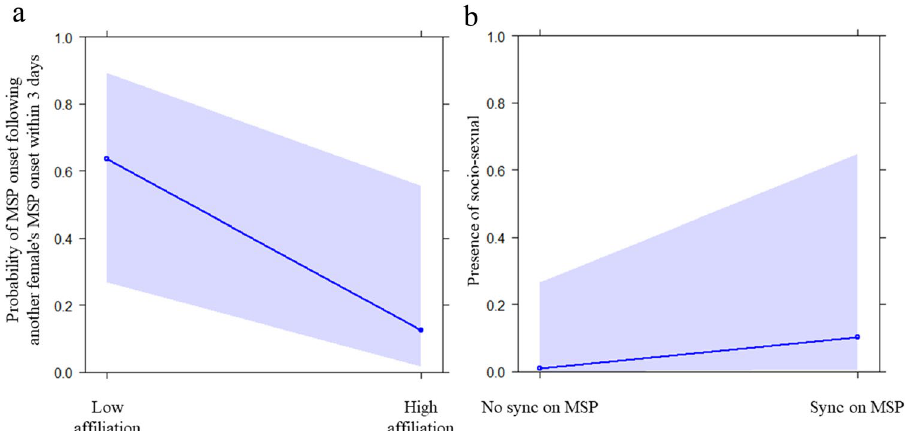
Figure 4. Effect plot of the variables having a significant influence on the occurrence of socio-sexual contacts in GLMM 2 and GLMM 3 ( a,b ; Table 2). ( a ) The probability of the MSP onset following another female’s MPS onset within three days (Y axis) was highest between females with low affiliation levels (X axis); ( b ) the occurrence of socio-sexual contacts between females (Y axis) increased when females were synchronized on MSP (Y axis).